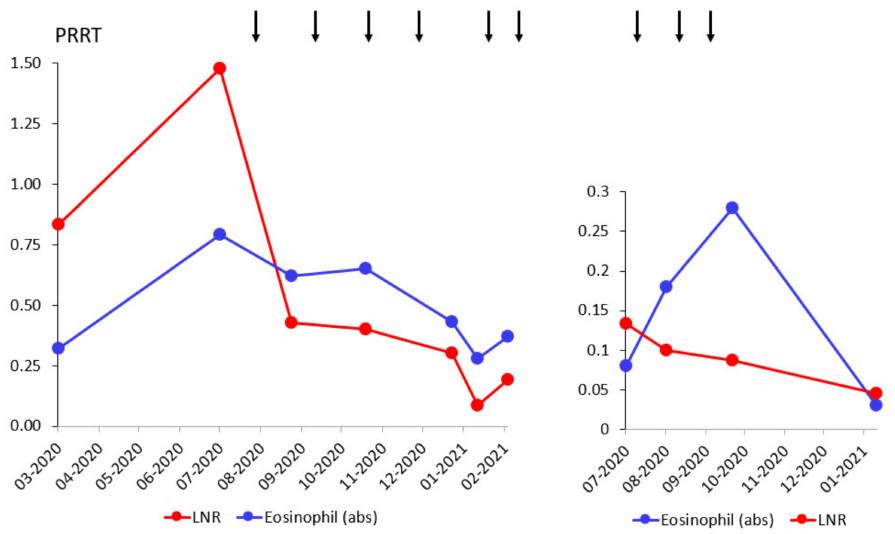
Figure 7. Lymphocyte to neutrophil ratio (LNR), and absolute eosinophil counts ( × 10 9 /L). Patient A ( left ), patient B ( right ). Arrows indicate the administration of